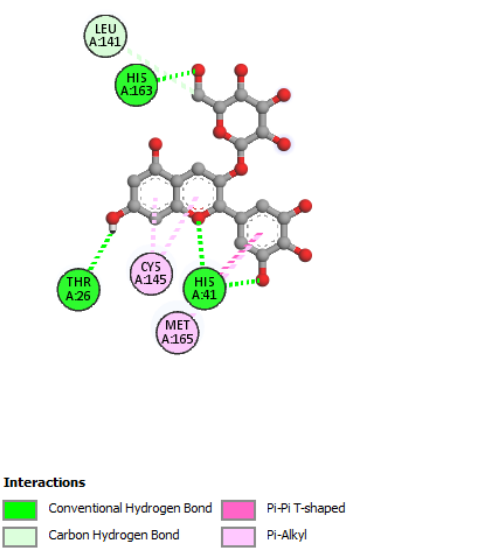
Figure 4 . ( A ) Interaction of delphinidin ( PubChem structure ) with Mpro ( without N3 ). ( B ) Interaction of delphinidin ( hemiacetal form ) with Mpro ( without N3 ). ( C ) Interaction of delphinidin ( hemiketal form ) with Mpro ( without N3 ). ( D ) Interaction of delphinidin ( quinonoid 1 form ) with Mpro ( without N3 ). ( E ) Interaction of delphinidin ( quinonoid 2 form ) with Mpro ( without N3 ). ( F ) Interaction of del- phinidin ( chalcone form ) with Mpro ( without N3 ).